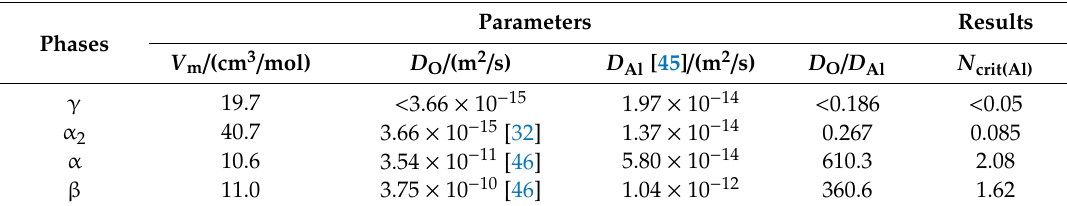
Table 4. Critical Al contents required for the transition from internal oxidation to external oxidation for the di ff erent phases in the subsurface of the Ti-46Al-2Cr-5Nb alloy at 1280 ◦